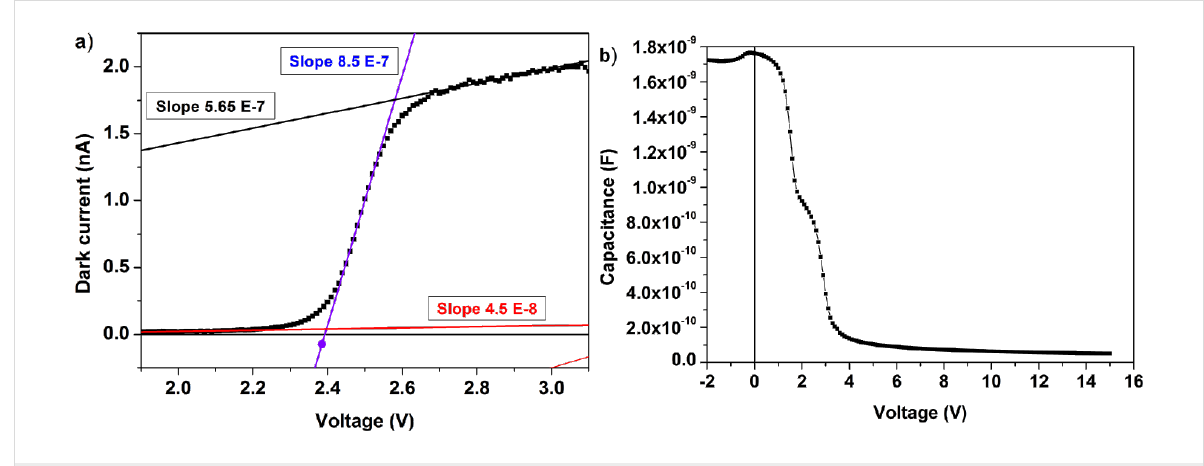
Figure 4: (a) Details of the dark current around the threshold voltage with a curve fit. (b) C–V plot of the heterojunction.